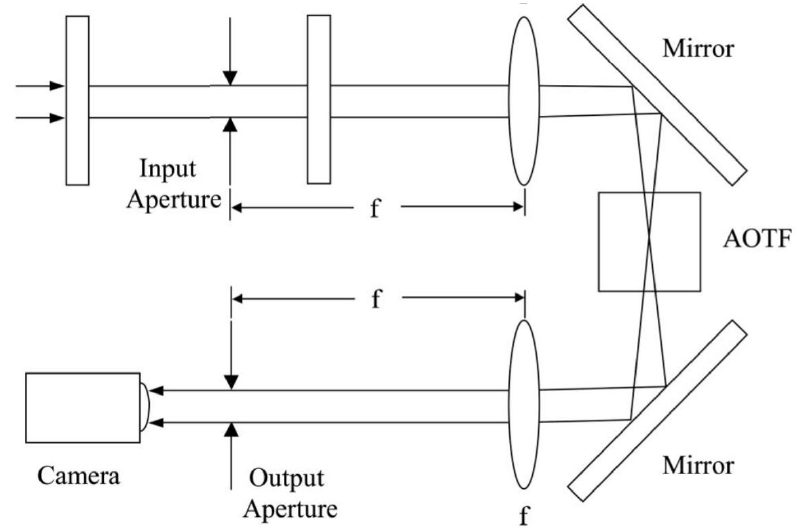
Figure 5. System principle diagram of imaging spectral polarizer based on acoustoptic filter type and liquid crystal phase tunable [21].